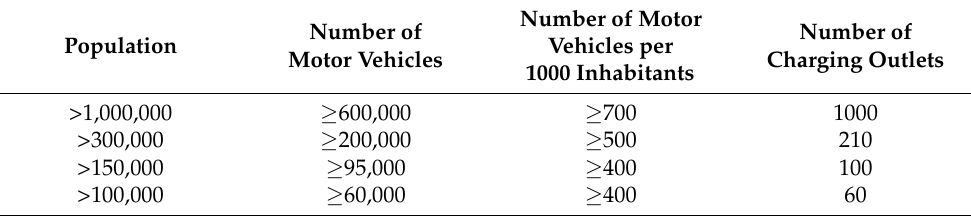
Table 2. Minimum number of charging outlets in publicly available charging stations in Poland (until 31 March 2021).